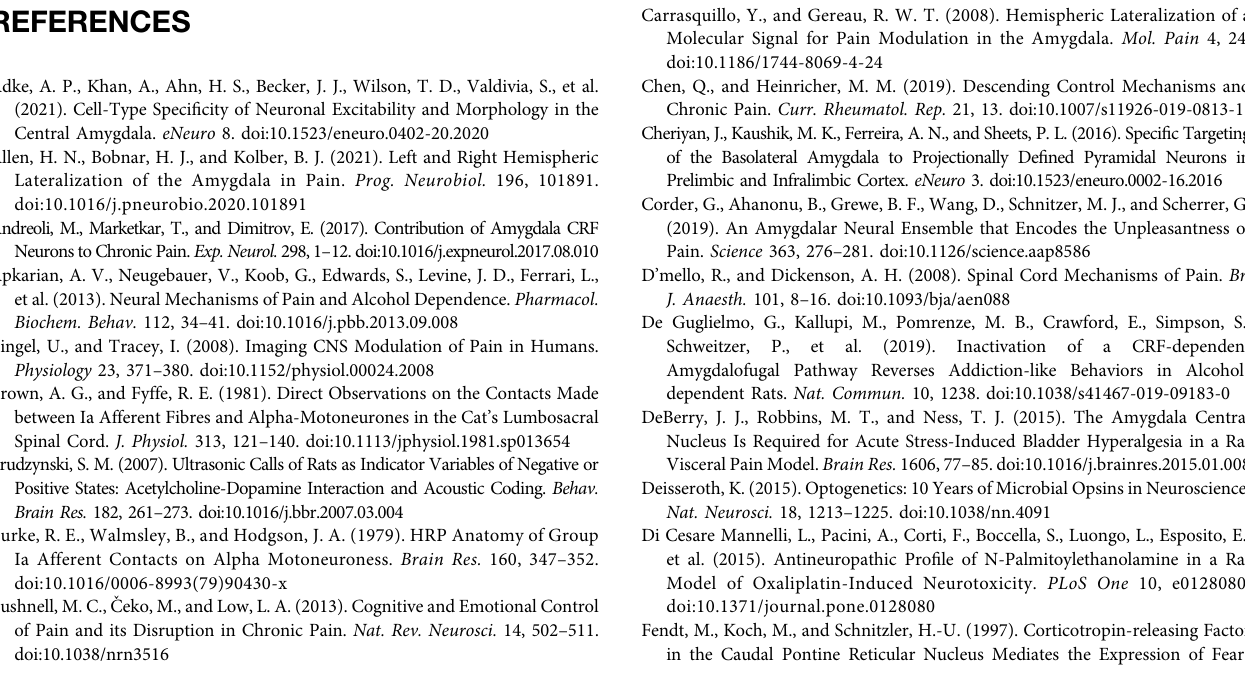
FIGURE S1 | Brain slice physiology validation of optogenetic strategy for BLA – CeA modulation. (A) Image of a biocytin labeled (recorded) neuron (light blue) in the CeLC,viralvector – mediatedYFPexpressioninBLA,andYFP – expressingBLAaxon terminals in CeA (green, eYFP). Recordings of a CeLC neuron (B) in current clamp show depolarization and induction of neuronal fi ring when continuous or pulsed (20 Hz) bluelight(5 – 10mW,5s) wasapplied (C) toactivate ChR2 – YFPexpressingBLA terminals in an amygdala slice from a normal rat. Neuron was manually depolarized to – 44 mV. Yellow light served as control. Scale bar 200 µm. (D, E) Recordings of another CeLC neuron. Same display as in (B, C) but with yellow light application to eNpHR3.0 expressing BLA terminals in an amygdala slice obtained from an arthritic rat. Blue light served as control. Neuron was manually depolarized to – 43 mV to generate action potential fi ring. FIGURE S2 | Brain slice physiology validation of optogenetic strategy for CeA-CRF modulation. (A) Image of a biocytin labeled (recorded) CeA – CRF neuron (light blue) co – expressingYFP andviralvector – mediatedYFP expression inCeA – CRFneurons (green, eYFP). Recordings of a YFP – expressing neuron in a brain slice from a transgenic Crh – Cre rat (B) in current clamp show depolarization and induction of neuronal fi ring when continuous or pulsed (20 Hz) blue light (5 – 10 mW, 5 s) was applied (C) to activate ChR2 expressing CeA – CRF neurons (slice obtained from a normal rat). Neuron was manually depolarized to – 53 mV. Yellow light served as control. Scale bar 100 µm. (D, E) Recordings of another CeA – CRF neuron. Same display as in (B, C) but with yellow light application to eNpHR3.0 expressing CeA – CRF neurons in an amygdala slice obtained from an arthritic rat. Blue light served as control. Neuron was manually depolarized to generate action potential fi